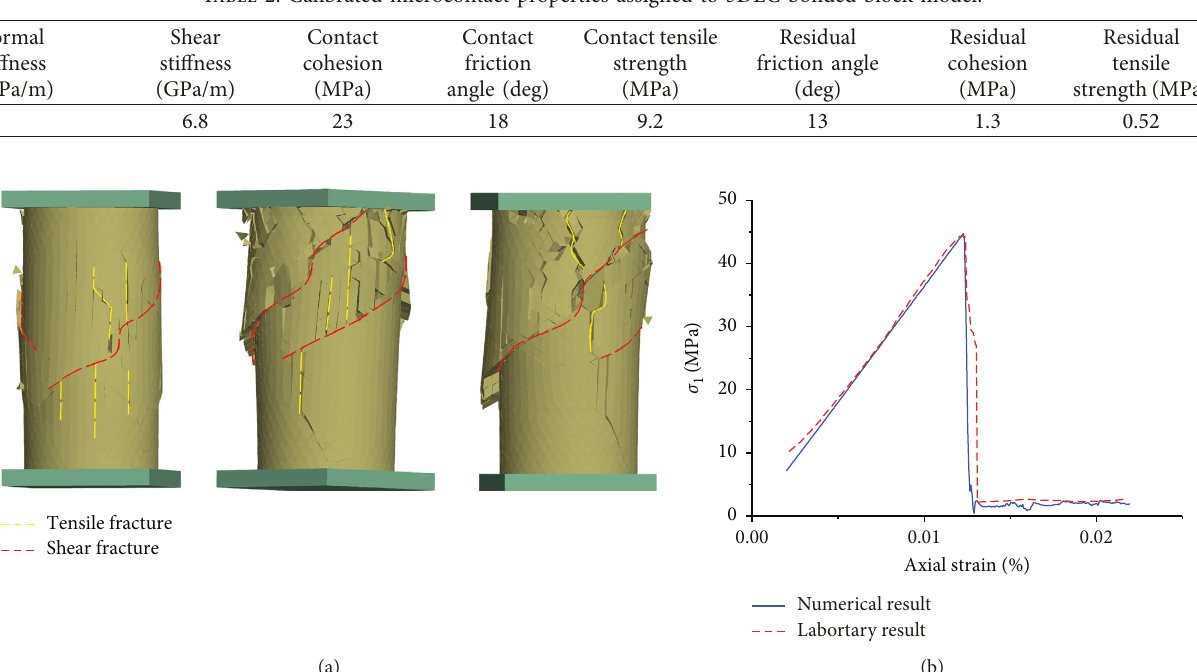
Figure 5: Numerical test result of uniaxial compression test. (a) Frontal views at different view angles of fracture mode, red dash line for shear fracture and yellow dash line for tensile fracture. (b) Stress-strain curve of the numerical test and the laboratory test of